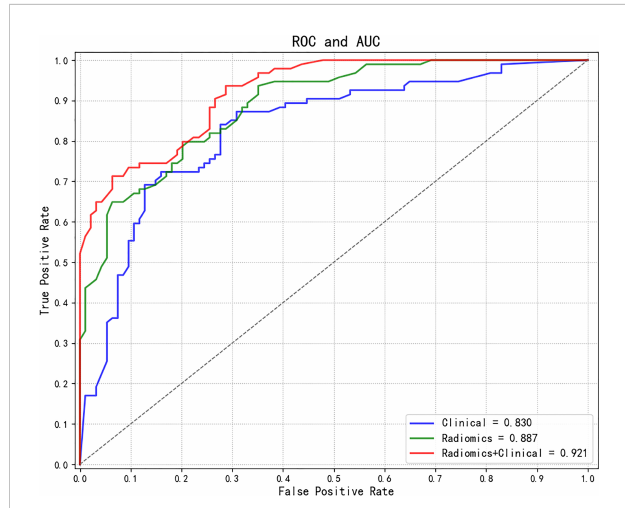
FIGURE 5 Comparisons of ROC curves of different models. ROC, receiver operating characteristic; AUC, area under the curve.